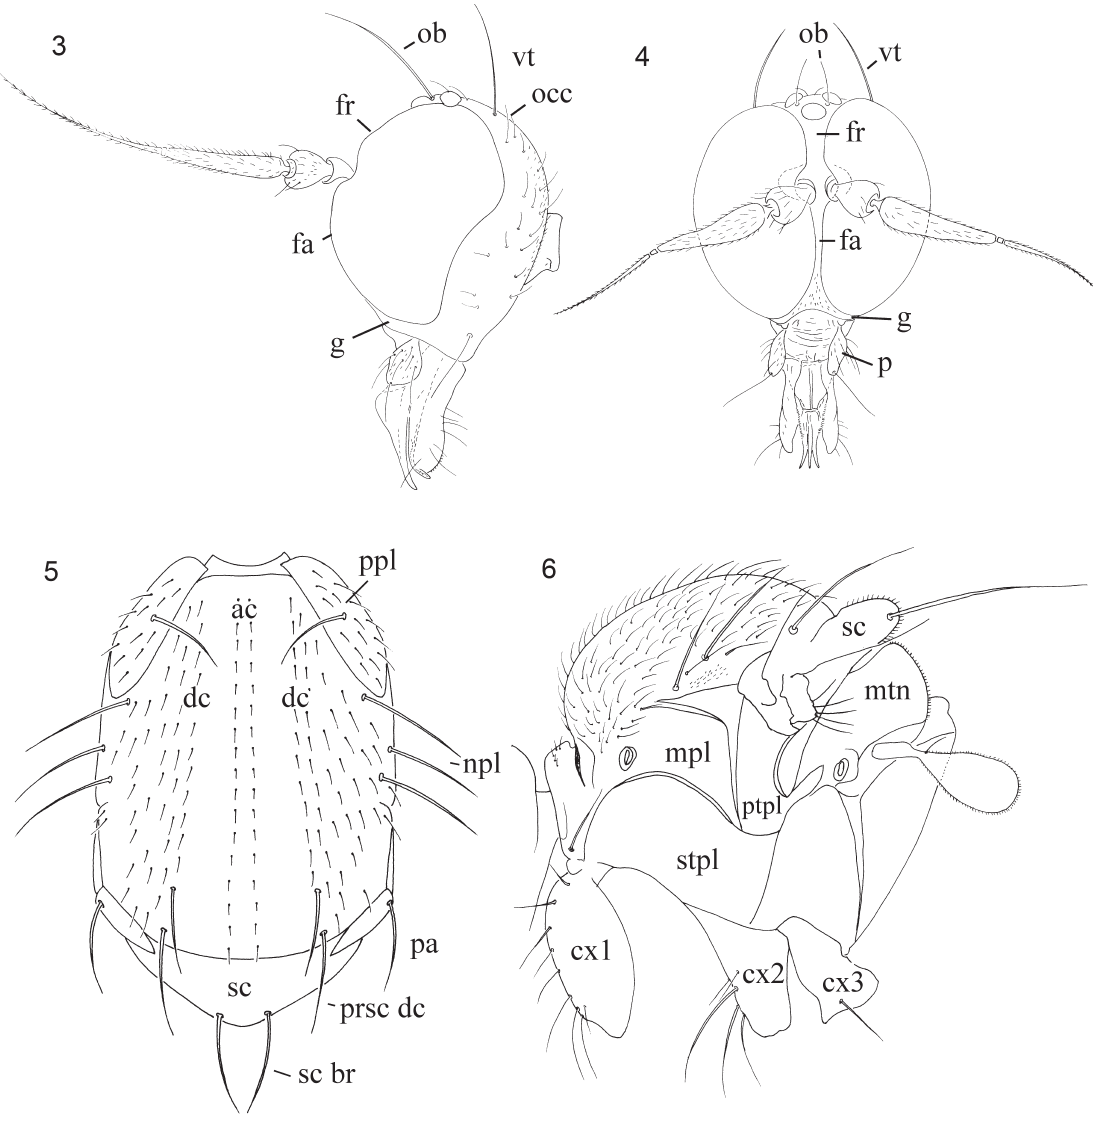
Figs 3-6. Elaphropeza biuncinata (Melander, 1928). 3 . head, ♂, lateral view. 4 . head, ♂, frontal view. 5 . Platypalpus sp. scutum dorsal view. 6 . E. biuncinata thorax, lateral